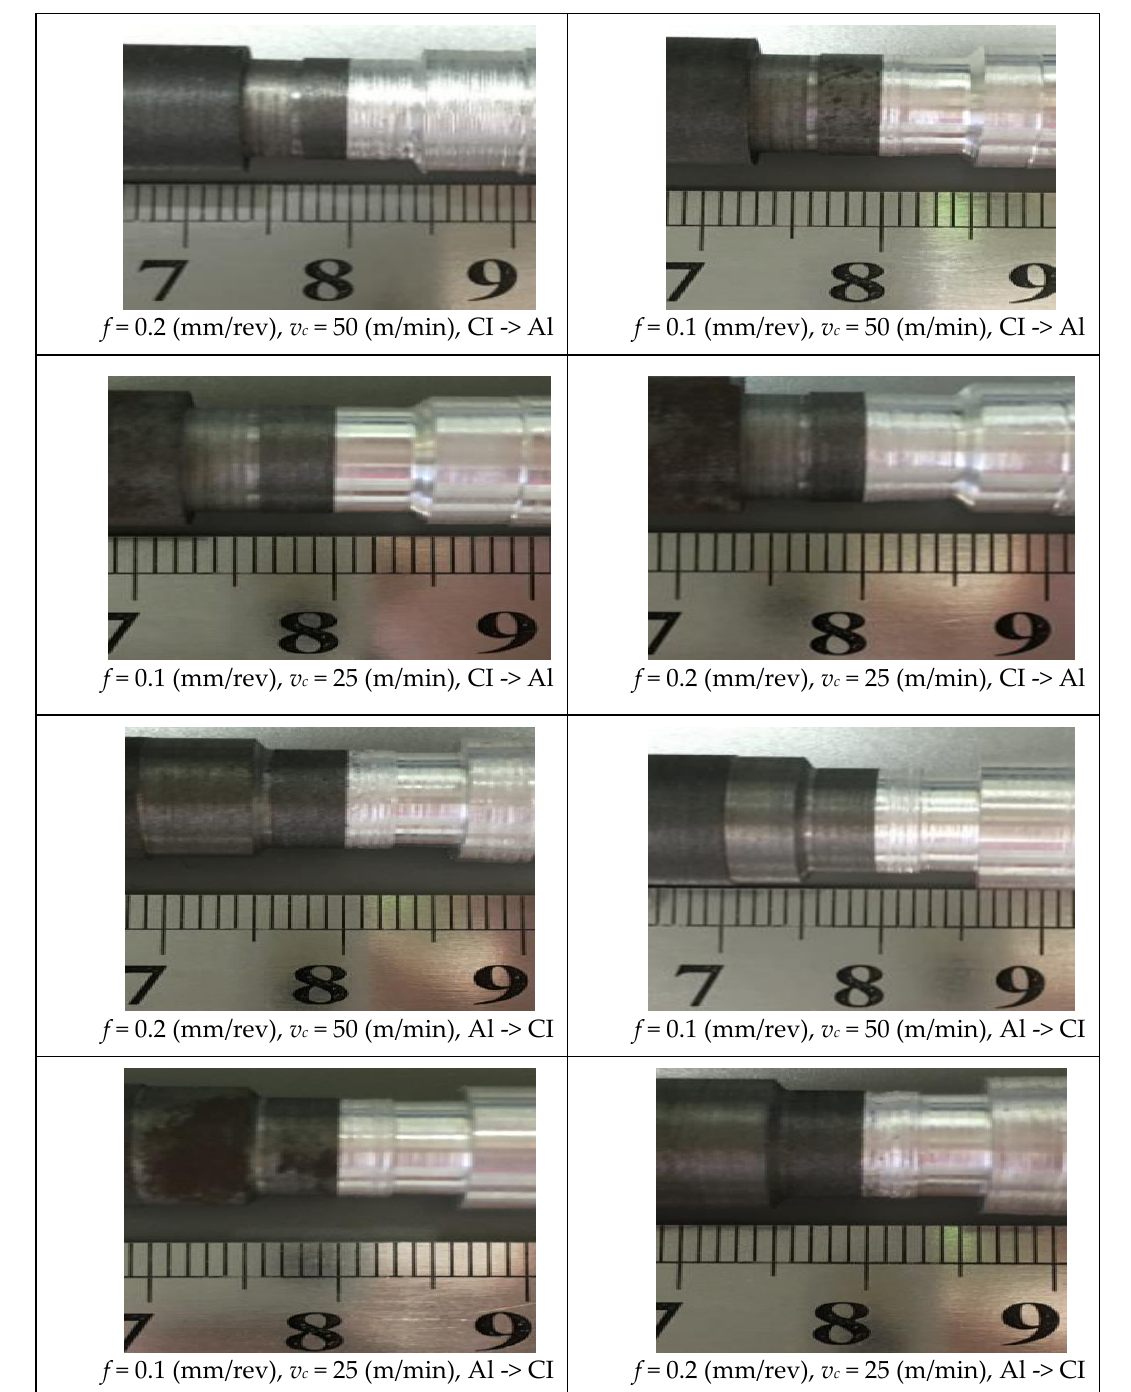
Figure A3. The Al–CI specimens.